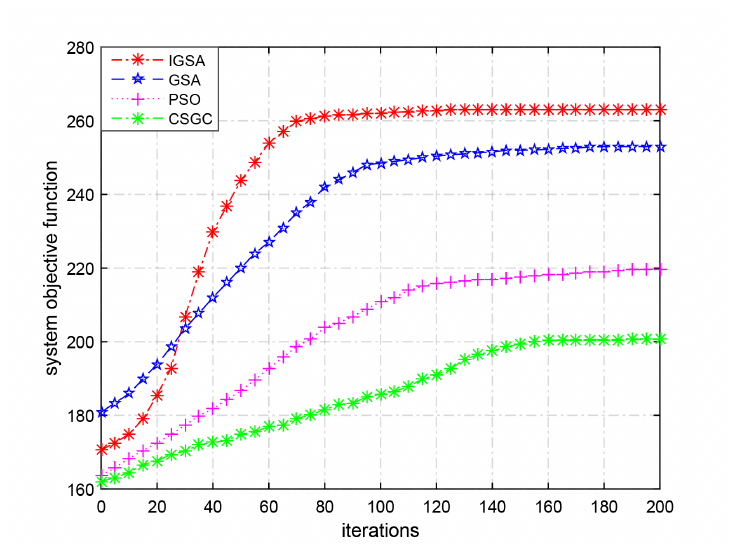
Figure 3. Convergence speed.